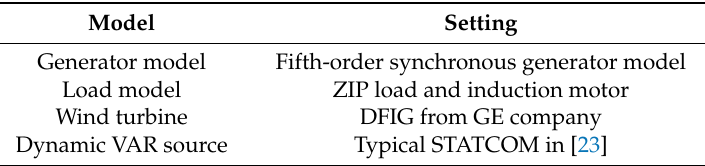
Table 1. Setting and parameters.